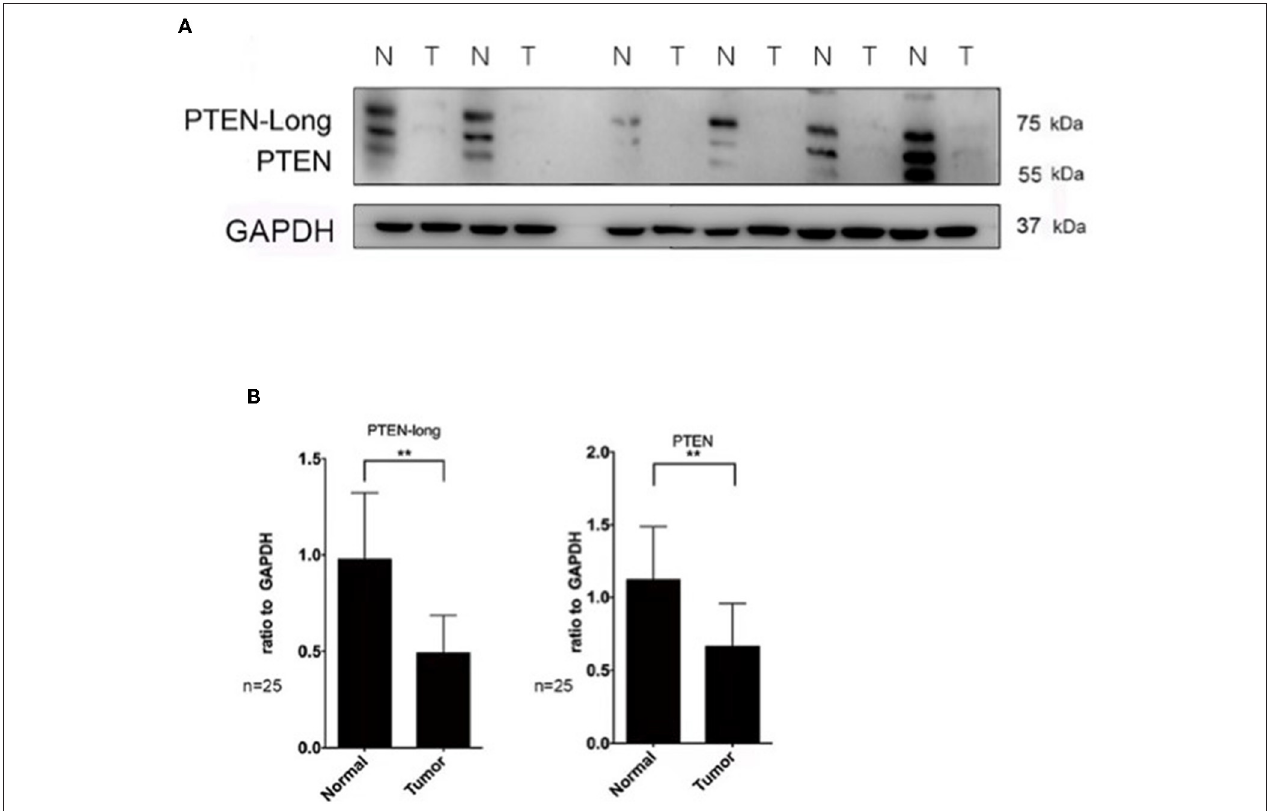
FIGURE 1 | The expression of PTEN-Long is significantly reduced in hepatocellular carcinoma. Western blot analysis of PTEN and PTEN-Long expression in tumor and adjacent normal tissues. (A) Immunoblot of six randomly selected PTEN hepatocellular tumors and the corresponding normal tissues ( N = normal, T = tumor). (B) The ratios of PTEN-Long to GAPDH and PTEN to GAPDH in 25 pairs of samples are presented (** P < 0.01).